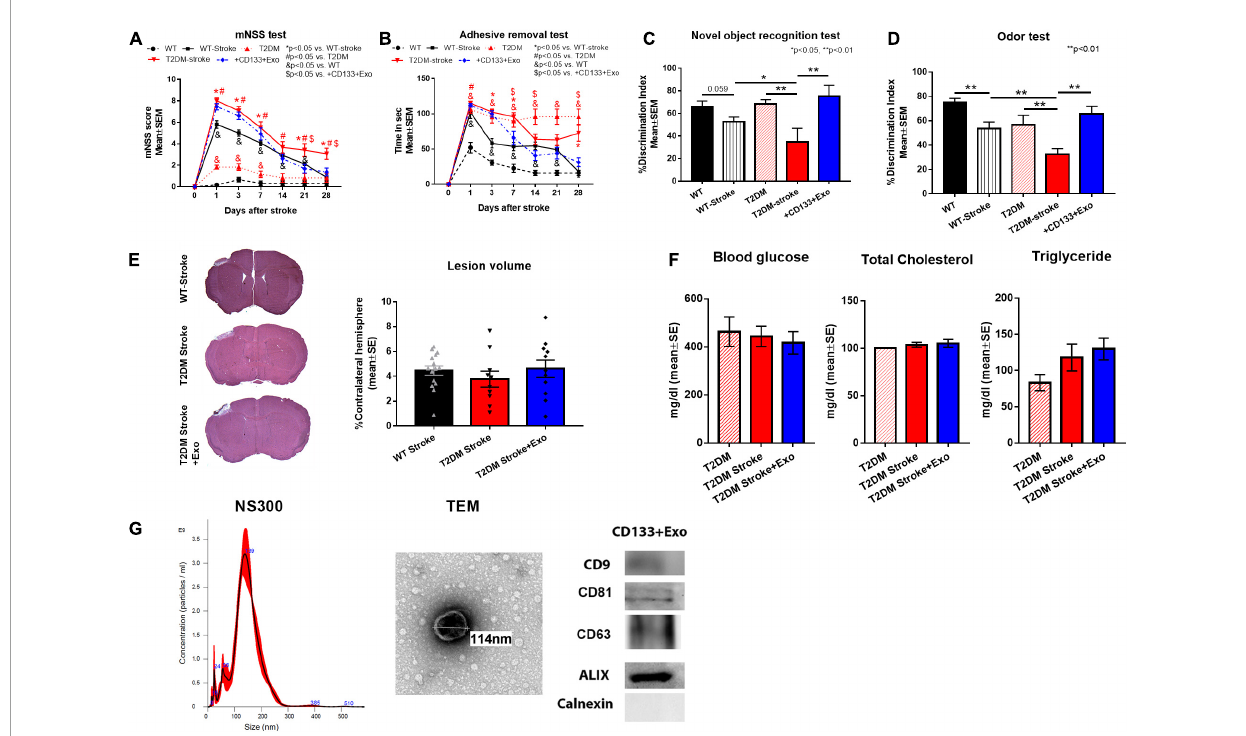
FIGURE1 CD133 + Exo treatment significantly improves neuro-cognitive outcome in T2DM stroke mice. (A,B) Stroke in T2DM mice induced severe neurological deficits indicated by higher mNSS scores and longer adhesive removal times compared to T2DM sham and non-DM stroke (WT-stroke) mice. Intravenous administration of CD133 + Exo at 3 days after stroke reduced neurological impairment indicated by significantly lower mNSS scores on days 21 and 28 after stroke as well as significantly shorter adhesive removal time on days 7, 14, and 28 after stroke when compared to T2DM-stroke mice. (C,D) Stroke in T2DM mice induced significant cognitive impairment indicated by lower discrimination index in NOR test and odor test at 28 days after stroke compared to T2DM sham and WT-stroke mice. Treatment of stroke with CD133 + Exo significantly improved both short-term and long-term memory evaluated by NOR and Odor test compared to T2DM stroke mice. (E) There were no significant differences in the lesion volume among non-DM stroke, T2DM-stroke and CD133 + Exo treated T2DM-stroke mice. (F) There were no significant differences ( p > 0.05) in blood glucose, total cholesterol or triglyceride levels at 28 days after stroke among T2DM, T2DM-stroke and CD133 + Exo treated T2DM-stroke mice. (G) Characterization of CD133 + Exo by NTA, TEM and Western blots. Non-DM (WT, n = 6), non-DM-stroke (WT-Stroke, n = 15), T2DM ( n = 8), T2DM-stroke ( n = 12), and T2DM-stroke + Exo ( n = 13).